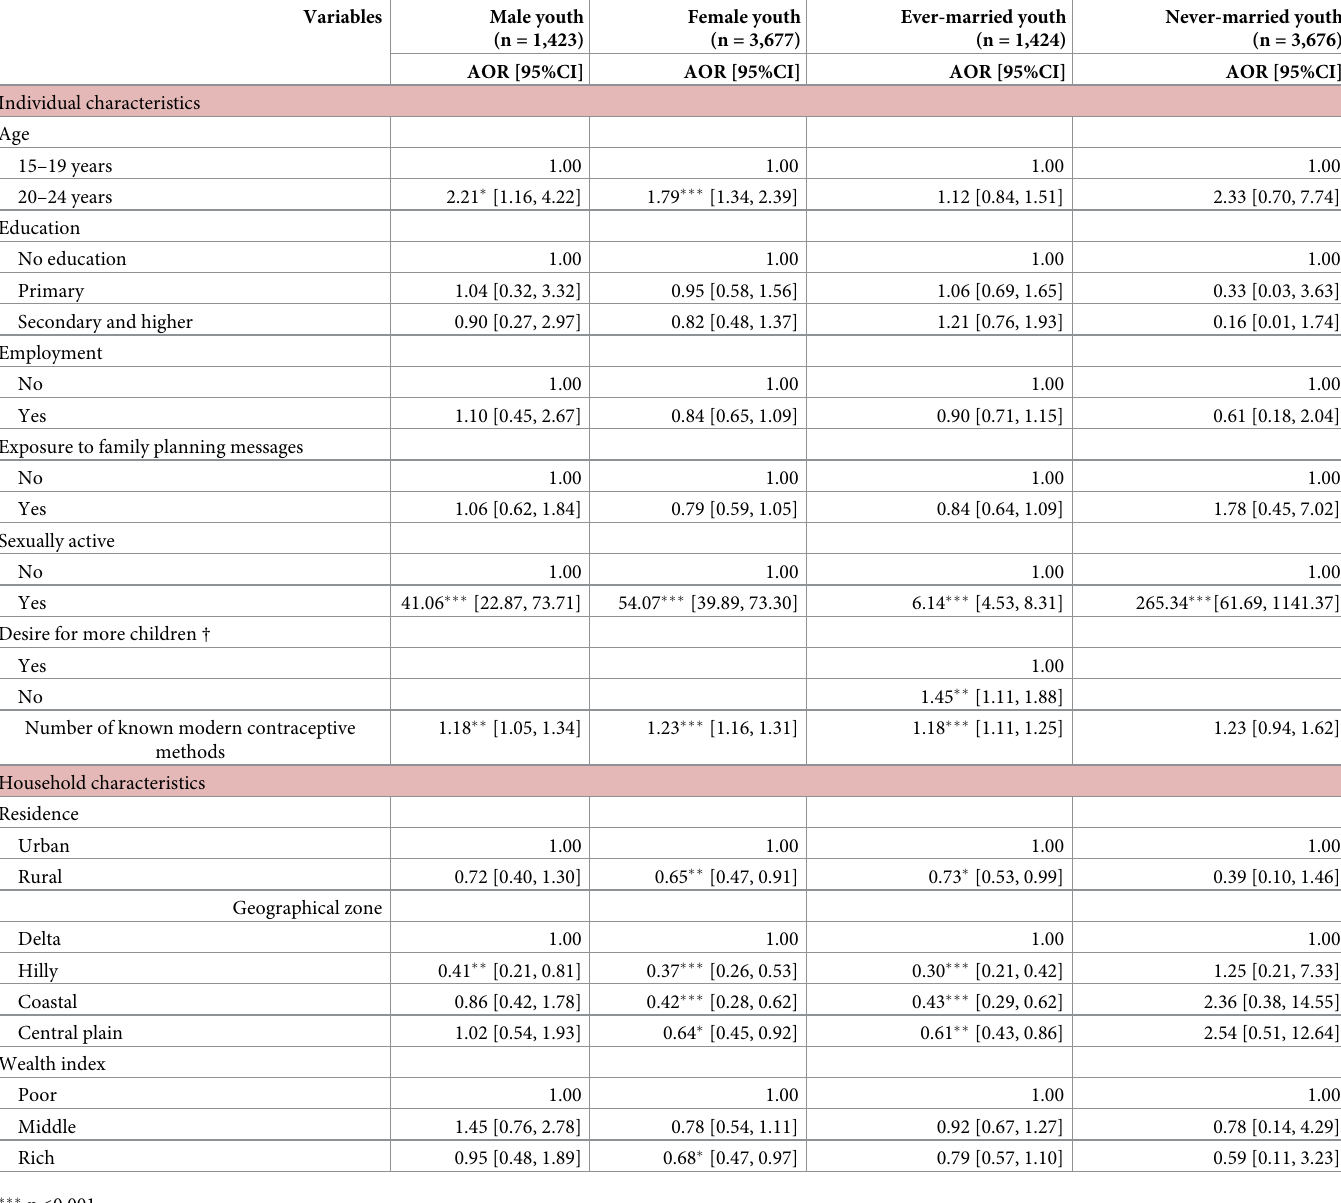
Table 6. Multivariable binary logistic regression analysis of modern contraceptive methods utilization among male youth, female youth, ever-married youth, and never-married youth in